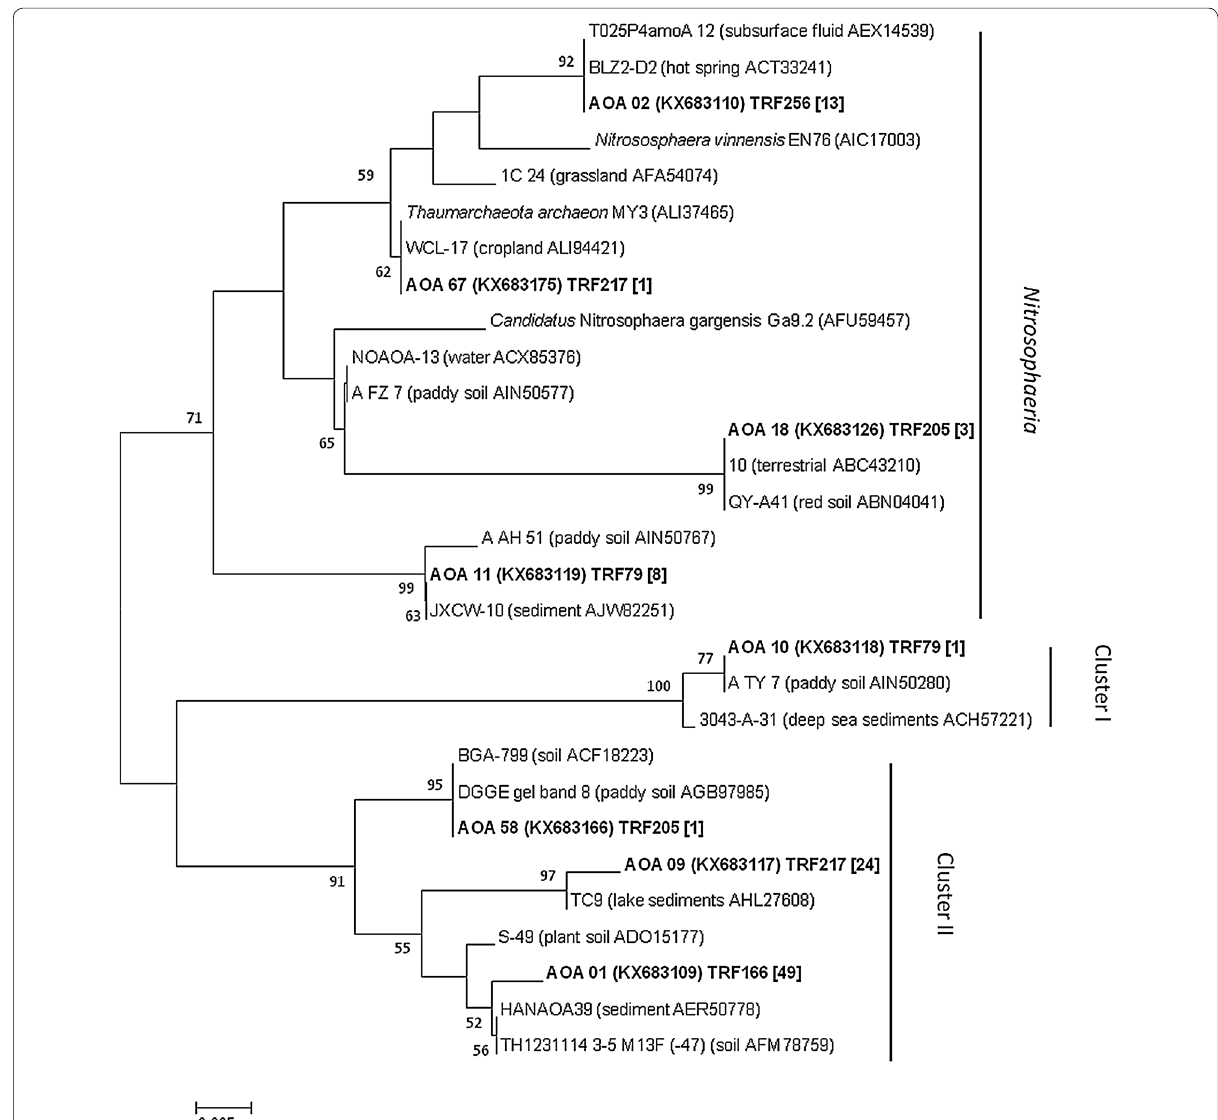
Fig. 6 Neighbor‑joining phylogenetic tree of AOA amoA gene sequences retrieved from the vegetable soil. Sequences from this study are shown in bold and are described as clone name (accession number) T‑RF size. Bootstrap values (>50%) are indicated at branch points . Reference sequences are described as clone name (environment, accession number). The number in bracket means clones. The scale bar represents 0.5%